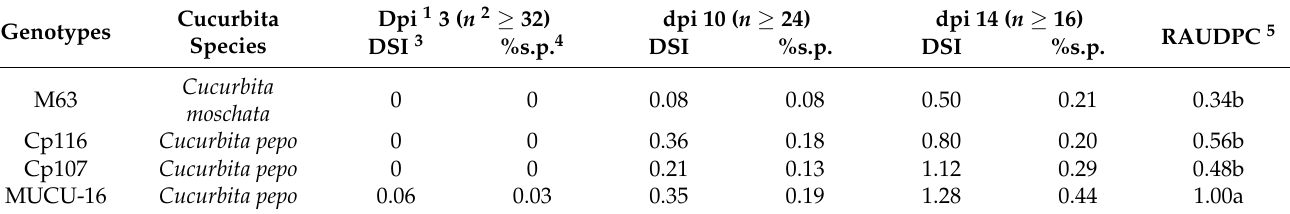
plants in the inoculated population. 5 Relative area under the disease progress curve for 19 days, with significant differences (ANOVA p = 0.0004, n = 3) indicated with letters (Tukey’s